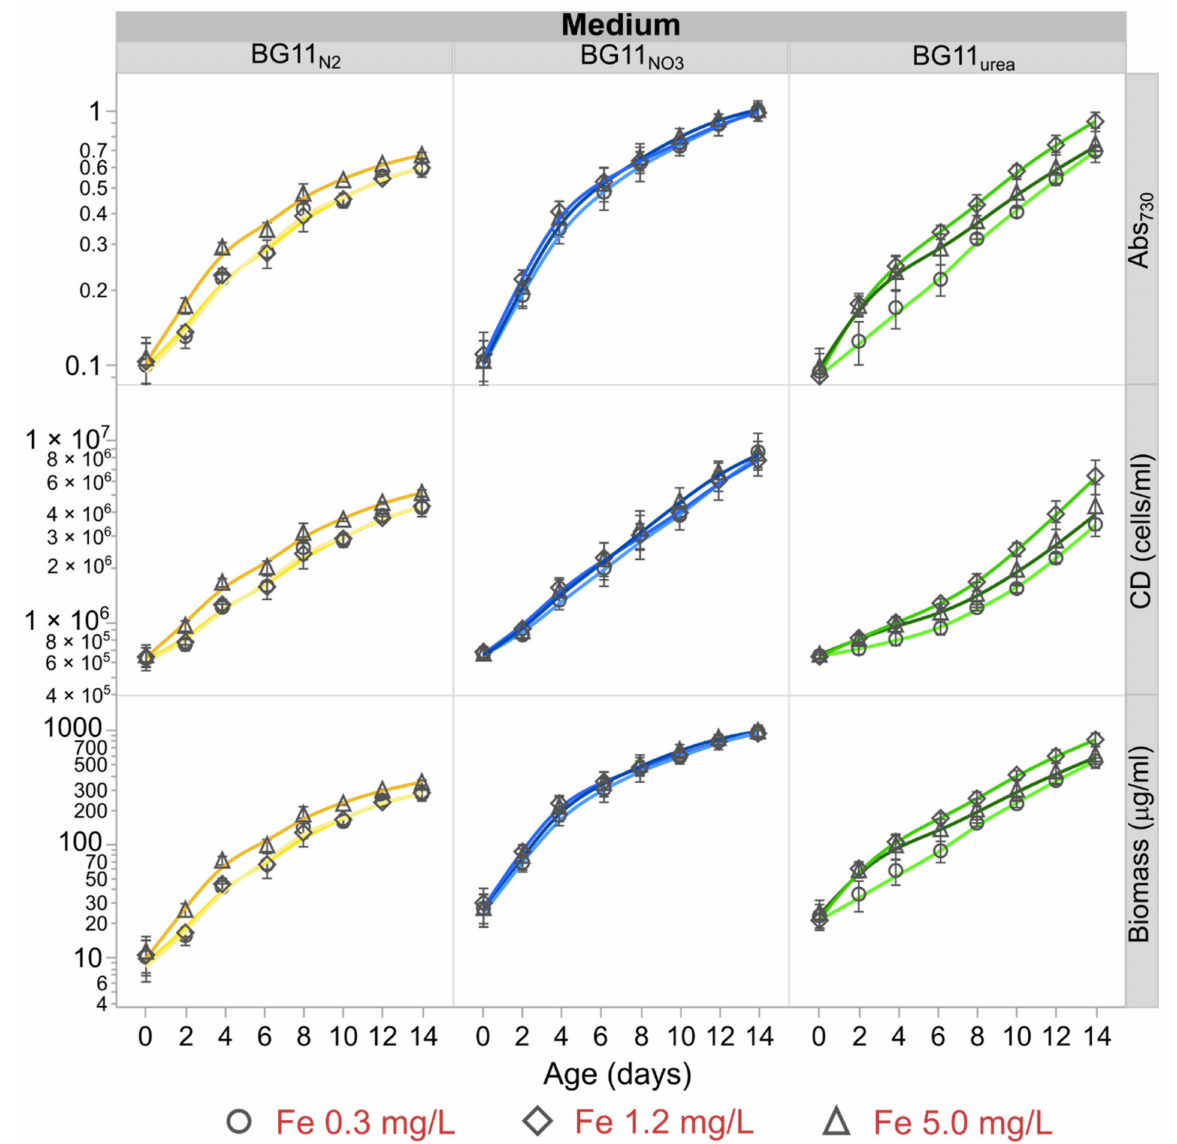
Figure 1. Growth kinetics of Anabaena in BG11 N2 , BG11 NO3 and BG11 urea. Fe concentration did not significantly affect cellular growth in BG11 NO3 , but higher biomass generation in BG11 urea cultures was observed with initial Fe supply of 1.2 mg/L. High Fe availability (5.0 mg/L) also favored growth and biomass generation in diazotrophic cultures (BG11 N2 ). Overall, cell growth was lowest in BG11 N2 medium, while BG11 urea cultures exhibited a longer exponential phase. Slowest growth was observed in BG11 urea with low Fe (0.3 mg/L). Highest biomass generation was observed in BG11 cultures. Absorbance at 730 nm was used as indicator of cellular density (second row) and biomass generation over time (third row). Starting nominal OD 730 (at day 0) was 0.1 for all cultures. Markers represent average values of three biological replicates and error bars are constructed using one standard error from the mean. Optical densities were measured in